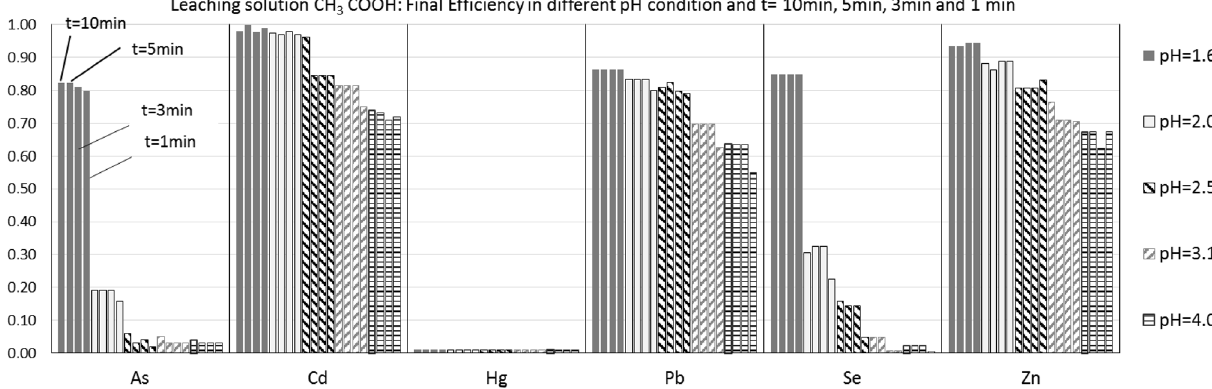
Fig. 7 Becker test: histograms of final extraction yield for As, Cd, Hg, Pb, Se and Zn with leaching solution CH 3 COOH in different pH conditions and for different conditioning times